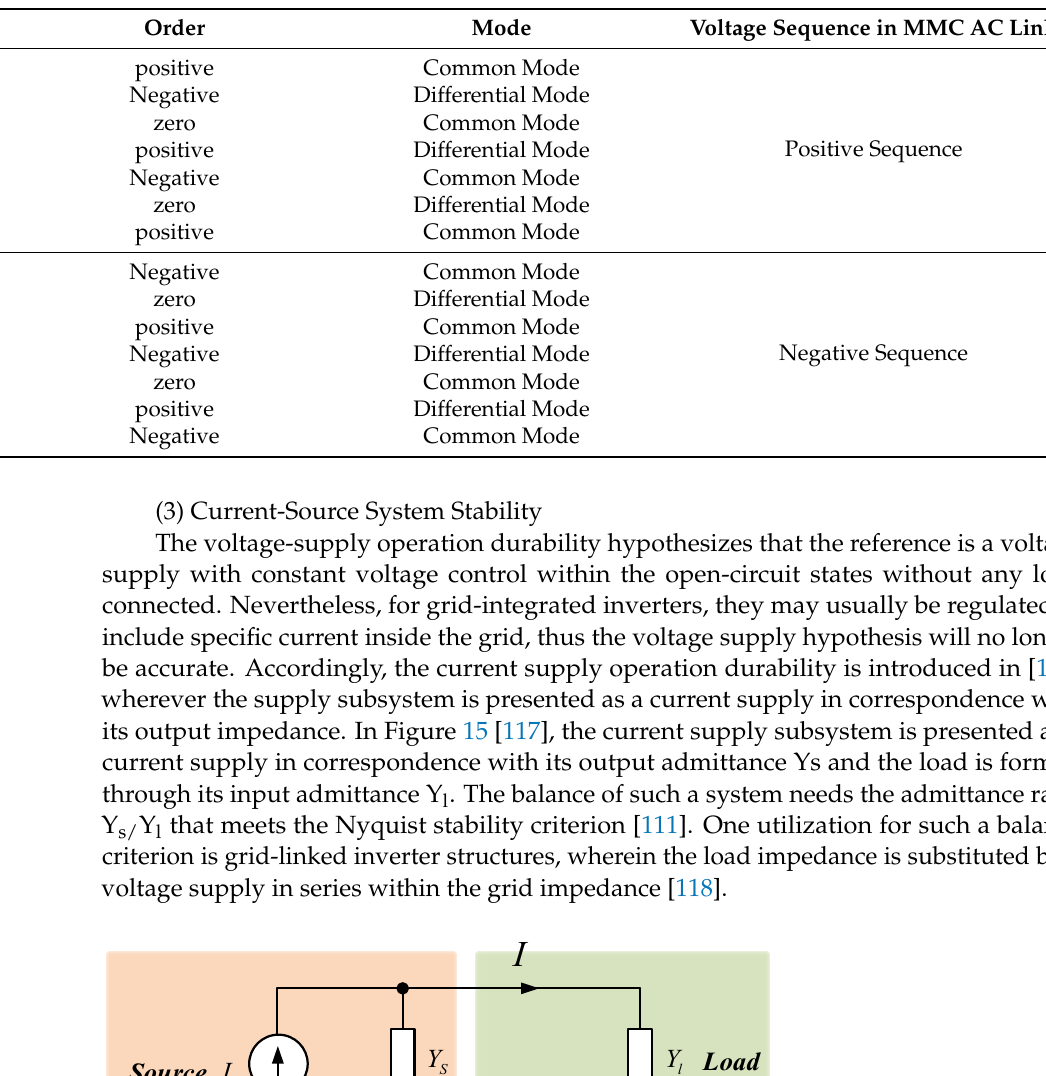
Table 5. Small-signal harmonics elements including frequency, order, mode of operation, and voltage perturbation sequence.